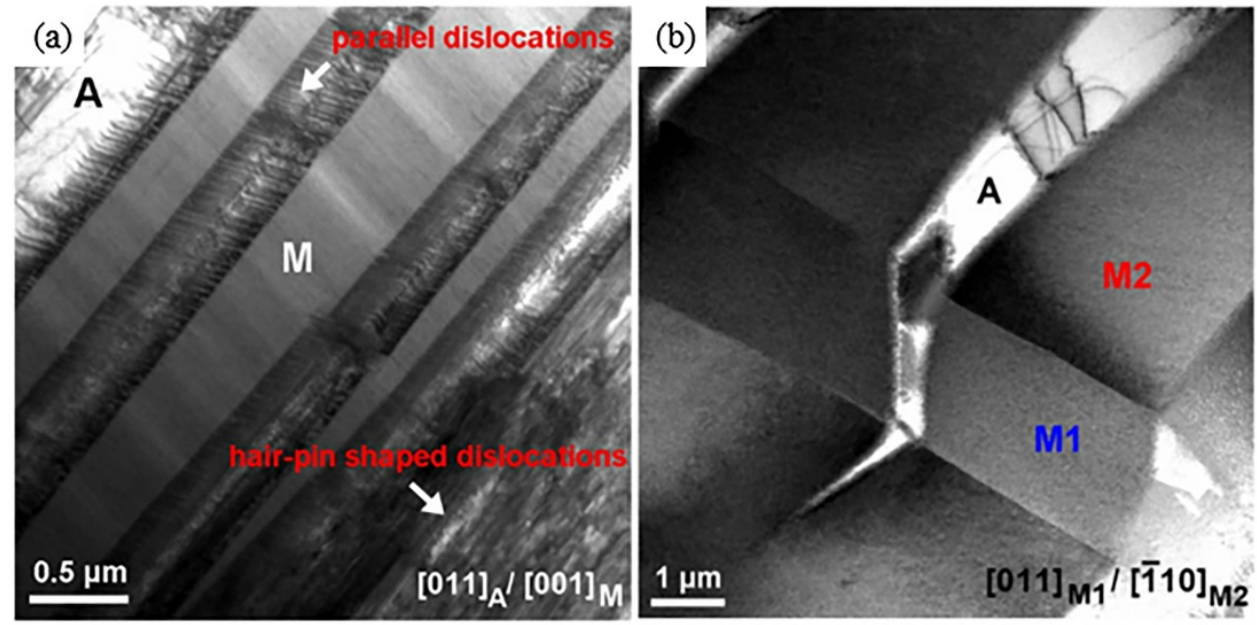
Figure 12. TEM bright field image of Fe-Mn-Al-Ni single crystal: ( a ) <100> orientation; ( b ) <123> orientation (A refers to austenite, M refers to martensite, M1 and M2 refer to two kinds of martensite variants) [102]. Reprinted with permission from Ref. [102]. Copyright 2016 Elsevier.